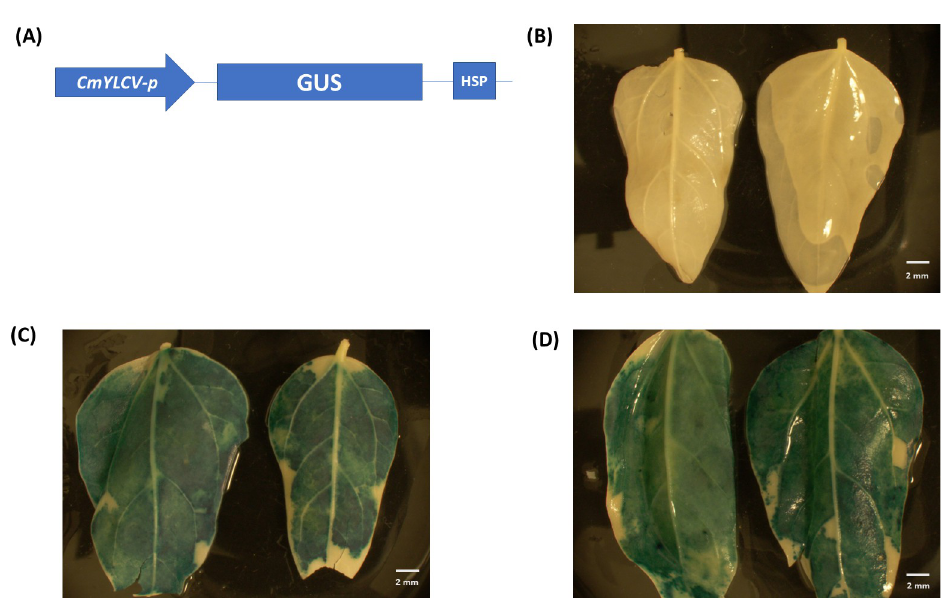
Fig 5. Transient GUS expression via agroinfiltration with CmYLCV promoter :GUS vector in cowpea leaves. (A) CmYLCV promoter :GUS construct used in this study. (B) Control leaves (infiltration with Agrobacterium strain AGL-1 without vector). (C) Cowpea leaves infiltration with Agrobacterium strain EHA105 containing CmYCLV promoter :GUS vector. (D) Cowpea leaves infiltration with Agrobacterium strain AGL-1 containing CmYLCV promoter :GUS vector.